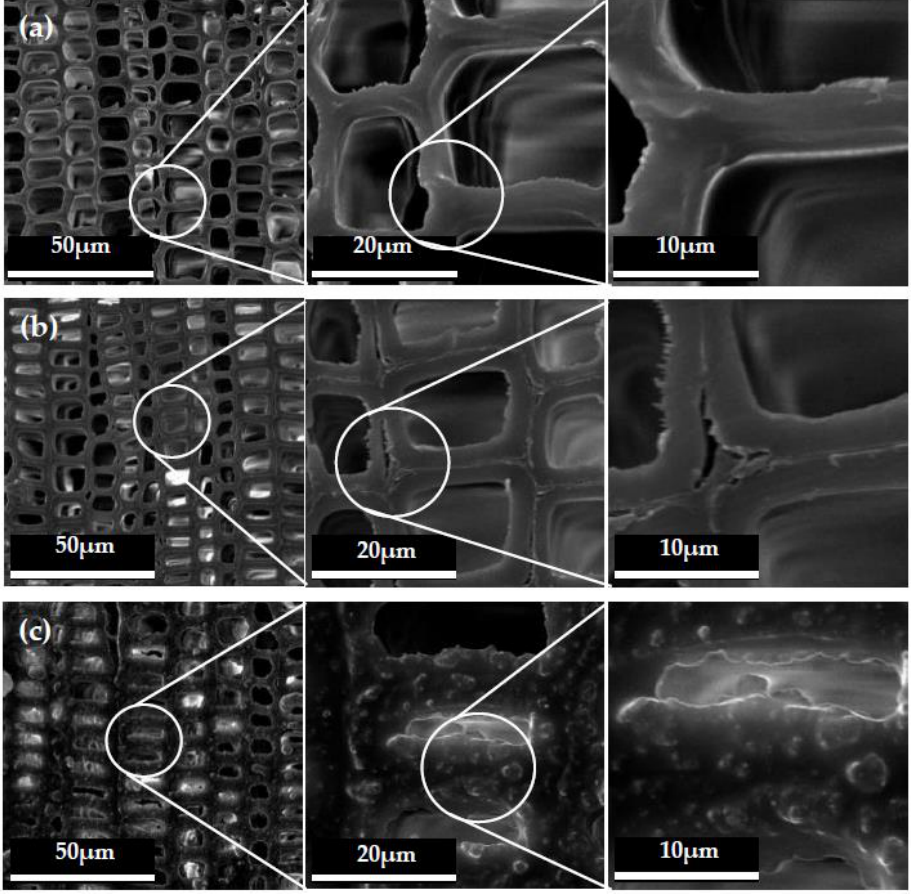
Figure 3. SEM morphology of wood cross section; ( a ) untreated wood; ( b ) with PDMS resin layer; ( c ) the hydrophobic surface with nano and micro hollow mesoporous microspheres.